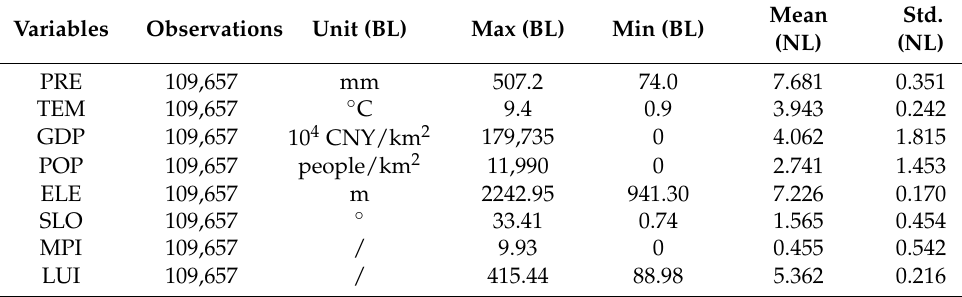
Table 2. Descriptive statistics of explanatory